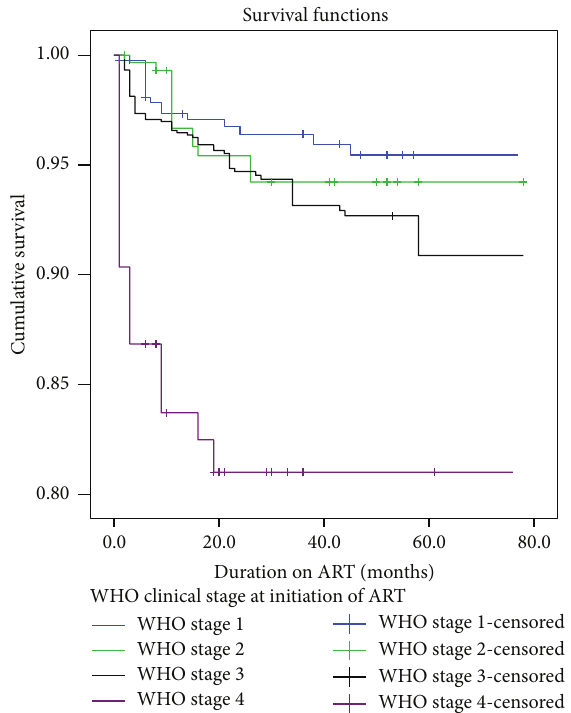
Figure 3: Survival function stratified according to initial WHO clinical stage among a cohort of ART clients; Goba hospital, Southeast Ethiopia;